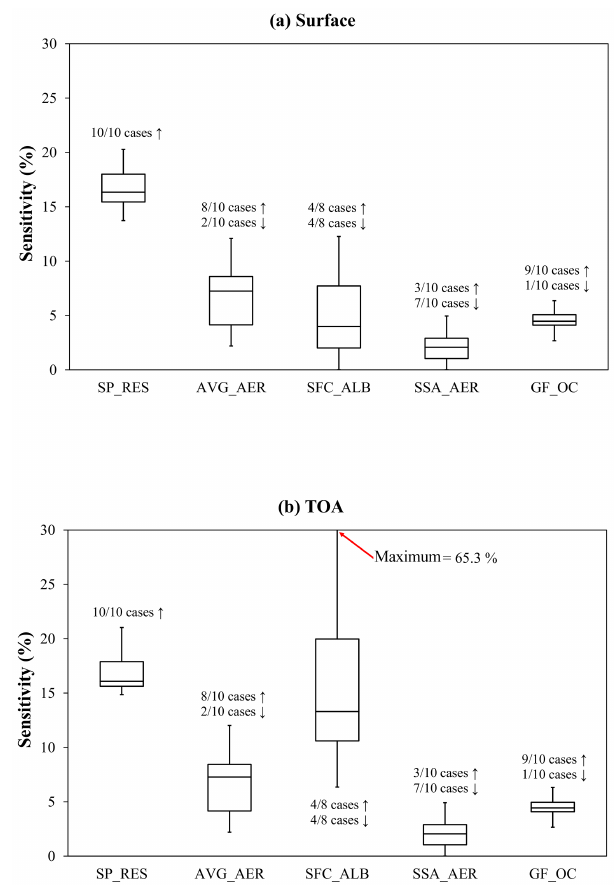
Figure 5. Sensitivity (in percentage) of the calculated aerosol ra- diative effect at the (a) surface and (b) TOA to the spectral reso- lution of the information used in the ES96 radiative transfer model (SP_RES), the aerosol description (AVG_AER), the surface albedo (SFC_ALB), the single-scattering albedo (SSA), and the hygro- scopicity of organic aerosol (GF_OC). The dividing segment in the box is the median. The bottom and top box limits represent the 1st and 3rd quartiles, respectively. The box bars represent the minimum and maximum. The number of cases with an increase ( ↑ ) or de- crease ( ↓ ) of the calculated aerosol radiative effect is also